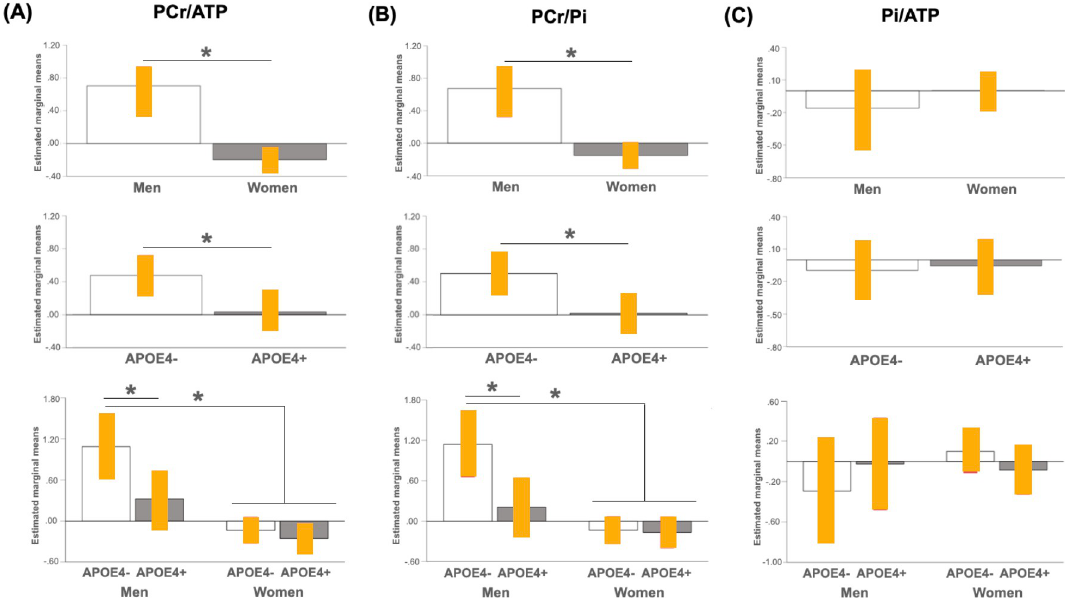
Fig 1. Effects of sex and APOE4 status on brain high-energy phosphates. Plots show mean high-energy phosphate (HEP) in frontal cortex for each pairwise comparison, with 95% confidence intervals (C.I.). � P < 0.05, corrected for multiple